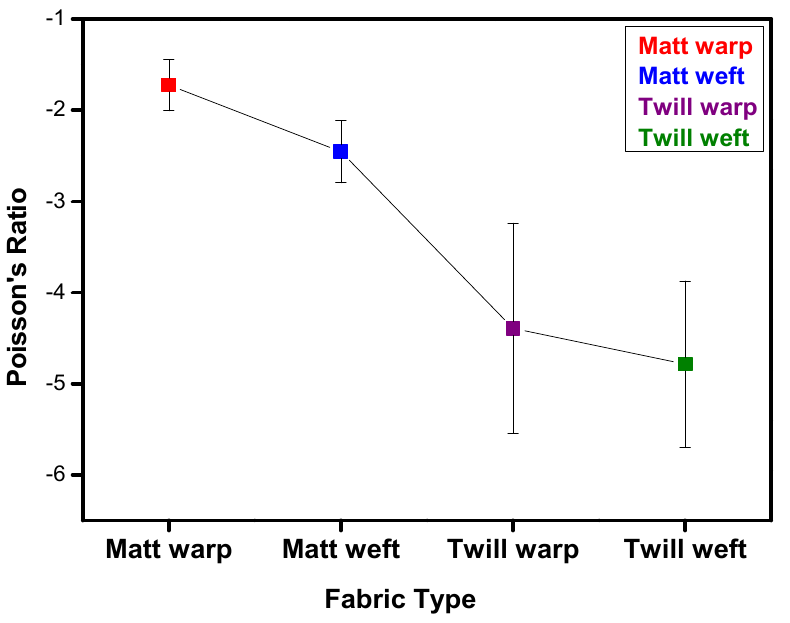
Figure 12. Out-of-plane Auxetic effect for all fabric samples having Poisson’s ratio with error bars